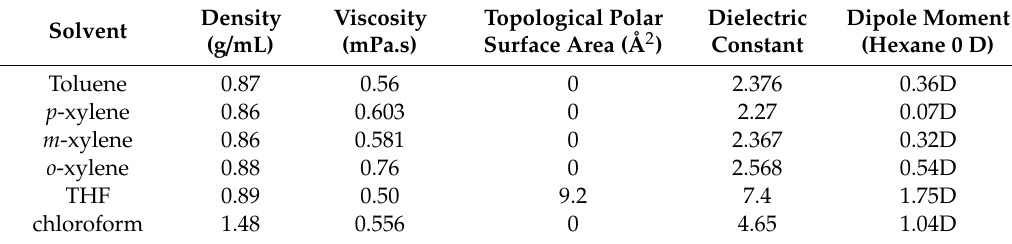
Table 1. Physical properties of commonly used solvents for sorting SWNTs